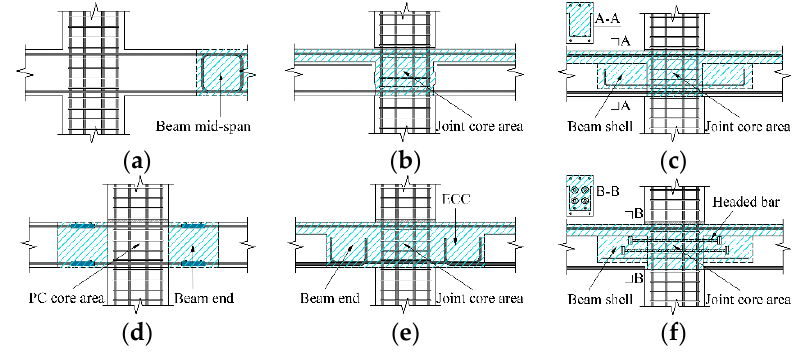
Figure 1. Emulated connection forms: ( a ) the connection located at the beam mid-span; ( b ) the connection located in the core area; ( c ) the connection located in the beam shell and the core area; ( d ) the connection located at the beam end; ( e ) the connection located at the beam end and in the core area; ( f ) the connection attached with headed bars.